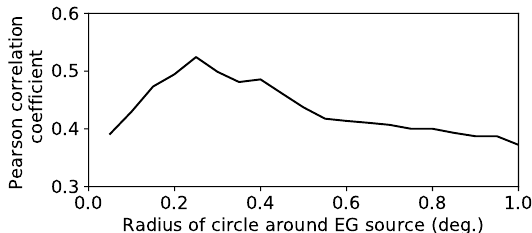
Figure 5. The Pearson correlation coefficient between the XE RM values averaged within circles of varying radii centred at each EG source, and the corresponding EG RM value. The correlation is strongest for XE areas with a radius of 0.25 ◦